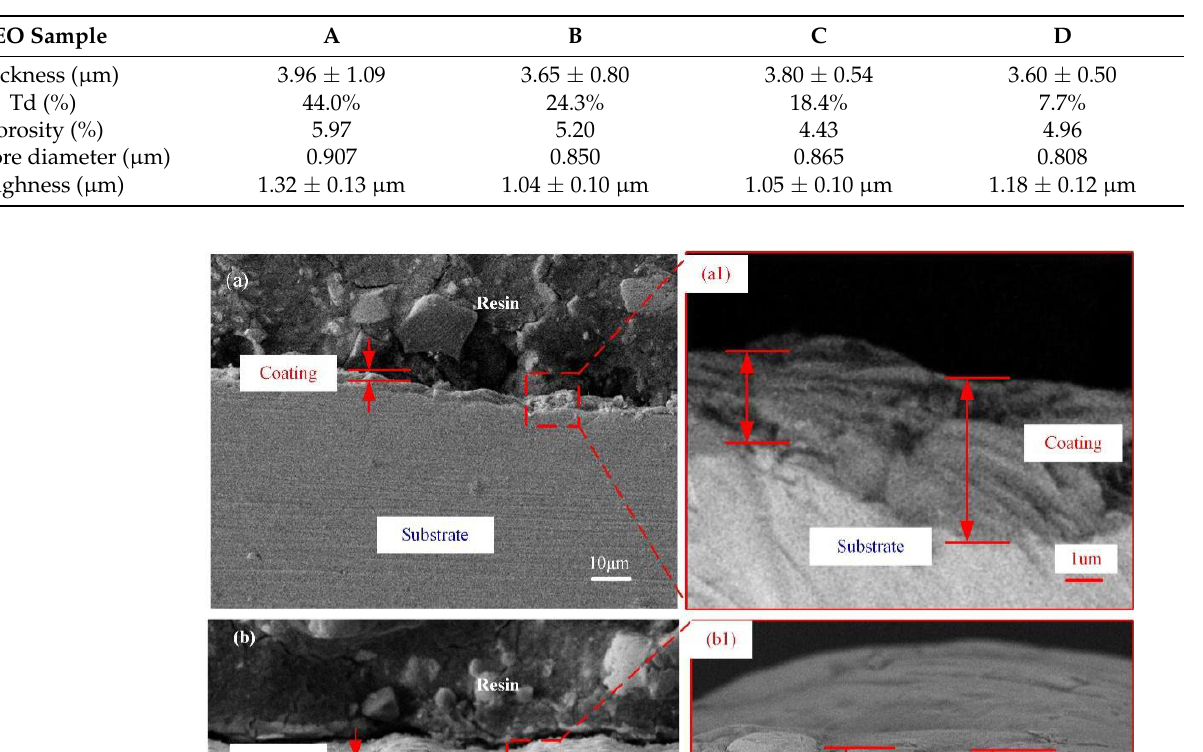
Table 1. Porosity, mean pore diameter, thickness, and thickness non-uniformity factor T d of PEO- coated samples.